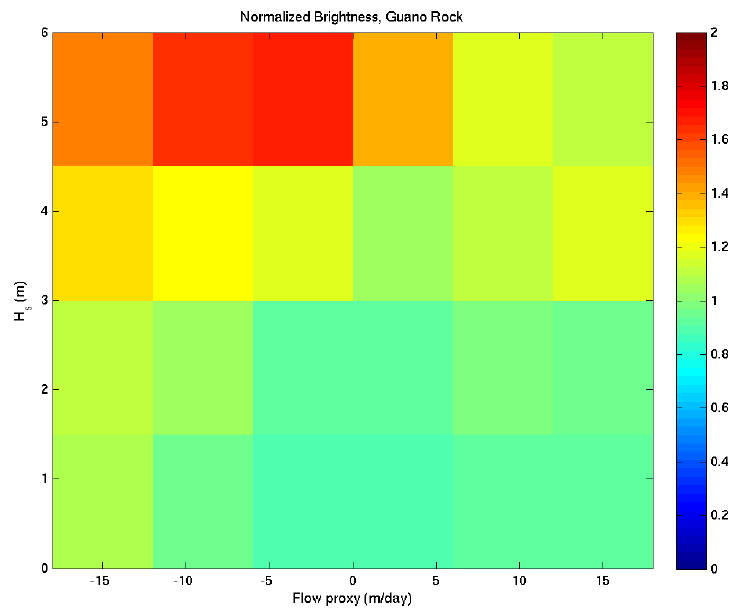
Figure 17. Normalized brightness of Guano Rock sampling region as a function of wave height and tidal flow (proxy).